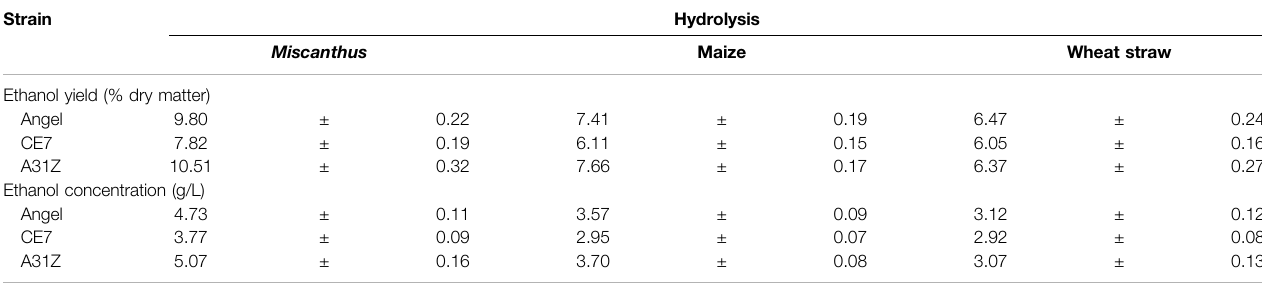
TABLE 1 | Ethanol yield (% dry matter) and concentration (g/L) of different yeast using the hydrolysis of Miscanthus , maize, and wheat straw. Strain